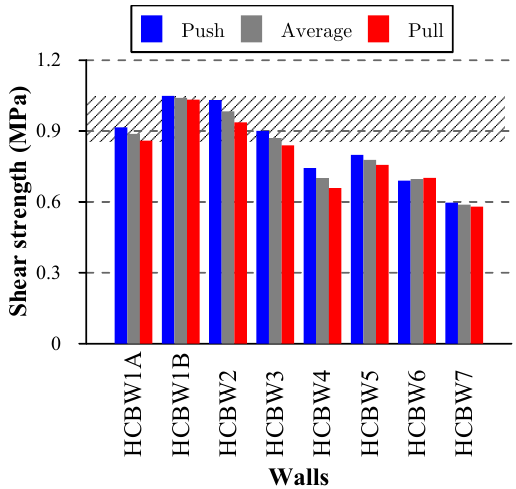
Figure 11. Loading direction effects on the shear